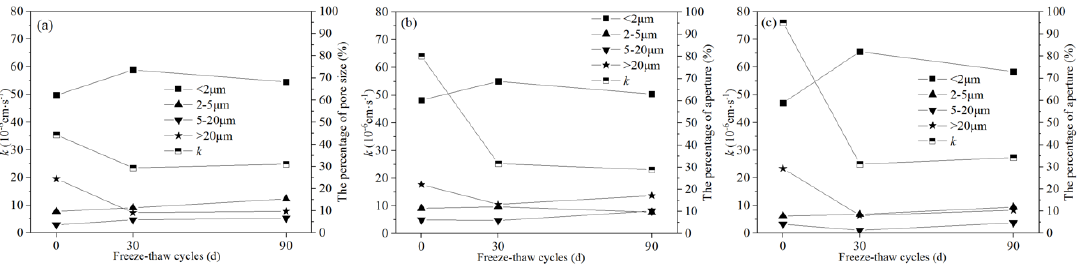
Figure 17. The k and pore size distribution of Pb-CSCSs: ( a ) C2.5S5F5; ( b ) C5S2.5F2.5, and ( c ) C5S5.